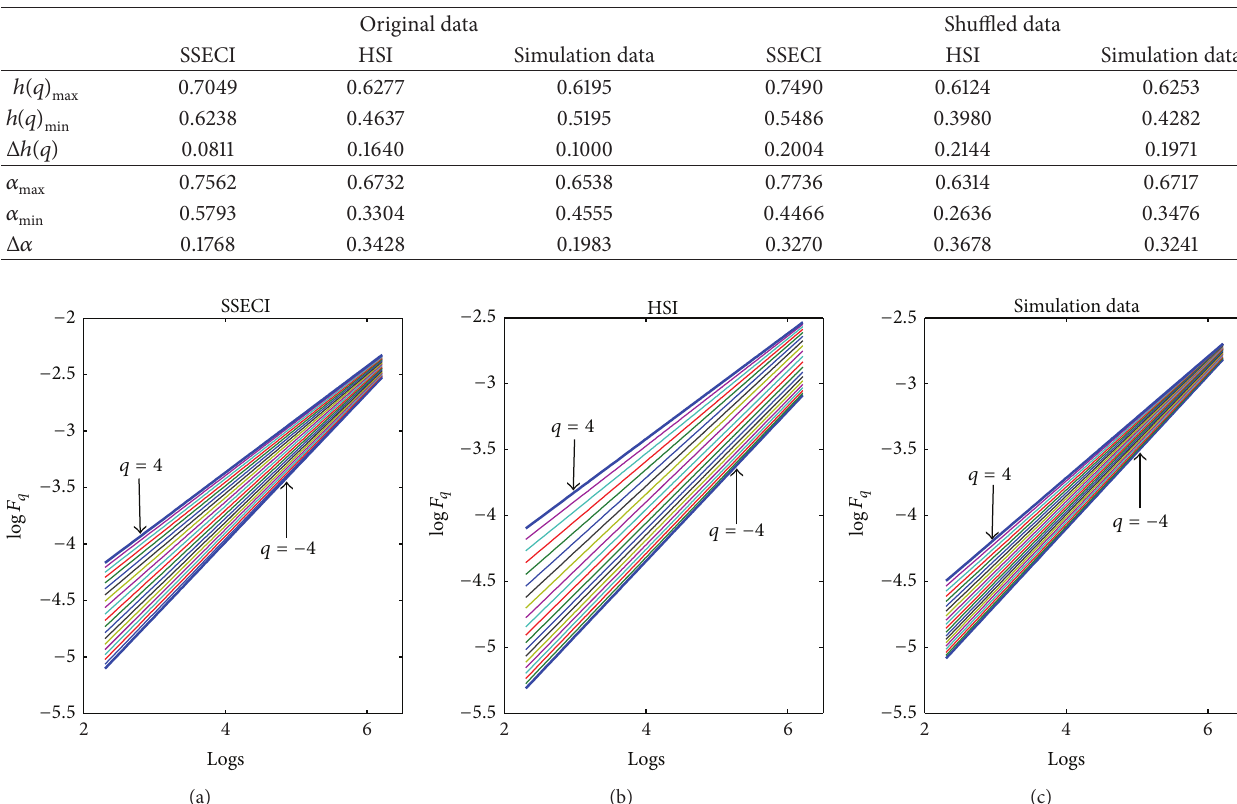
Figure 5: Log-log plots of 𝐹 𝑞 (𝑠) versus 𝑠 for SSECI, HSI, and the simulation data with different 𝑞 between − 4 (bottom line) and 4 (top